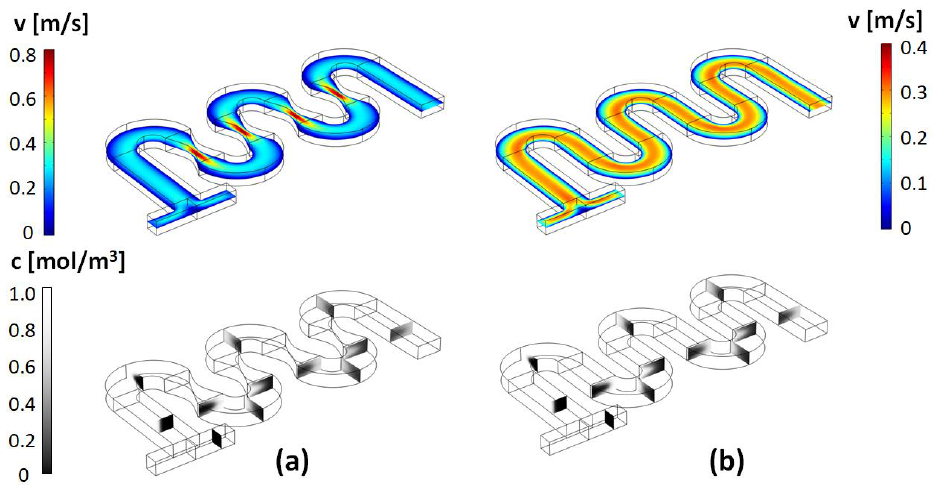
Figure 4. Velocity magnitude and concentration maps for the ( a ) design with a = 35 μ m and b = 2 × a ; and ( b ) the corresponding simple serpentine channel ( Re = 20).